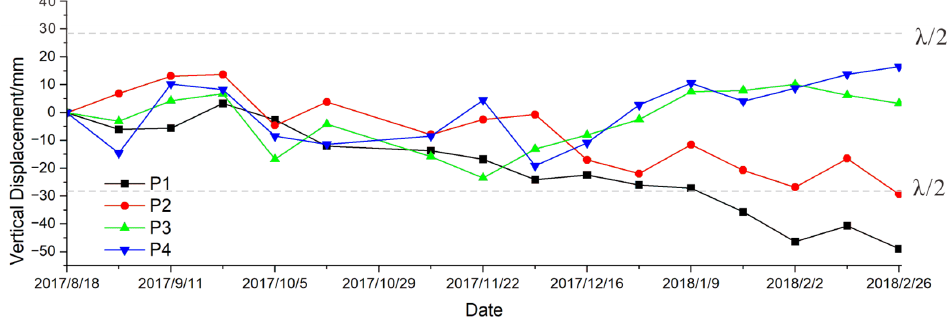
Figure 16. Time series deformation diagram of sampling points in region 1. The gray dotted lines are ambiguity (wavelength/2).